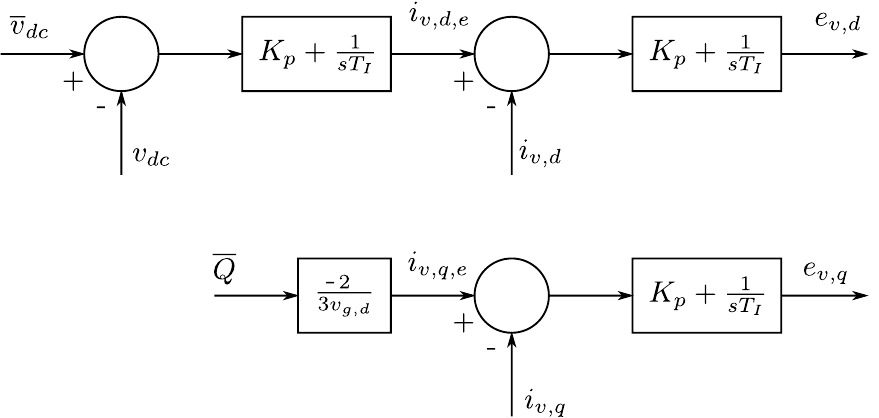
Figure 7. Master terminal cascaded control structure for regulating the DC voltage and the output